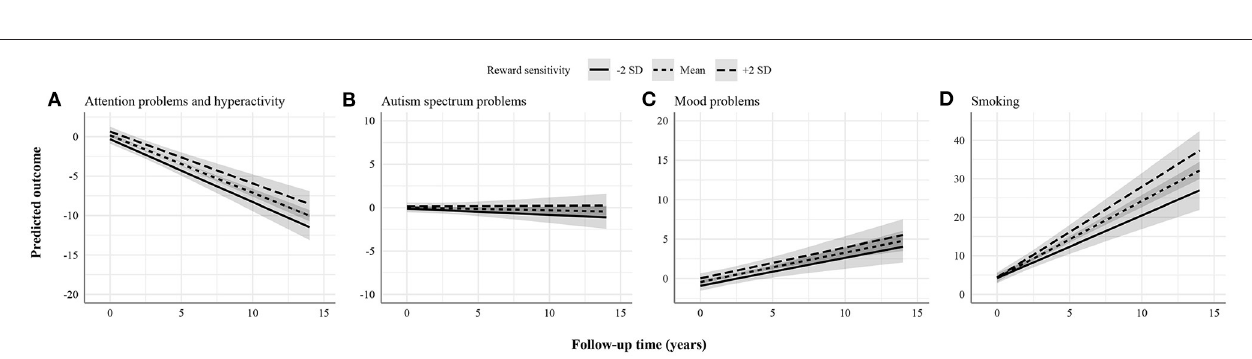
FIGURE 2 | Statistically significant increasing associations between reward sensitivity and psychopathology domains. (A) Alcohol use. (B) Cannabis use. The figures display the effect of reward sensitivity on psychopathology based on its main effect and in interaction with time. Here, the x-axes show follow-up time in years, whereas the different lines show reward sensitivity levels at 2 SD above and below the mean. The y-axes represent the predicted outcome with all covariates at mean levels and sex coded as 0 (males). The y-axes are only partly shown for better visualization of the findings.